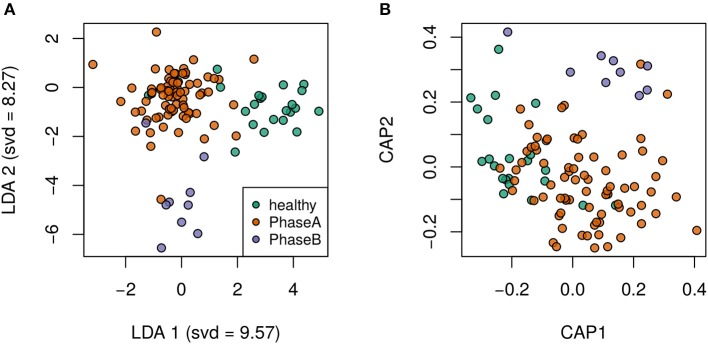
Clear separation by health status was observed via supervised discriminant analyses. (A) Linear discriminant analysis plot. (B) Bray-Curtis distance-based redundancy discriminant analysis plot.